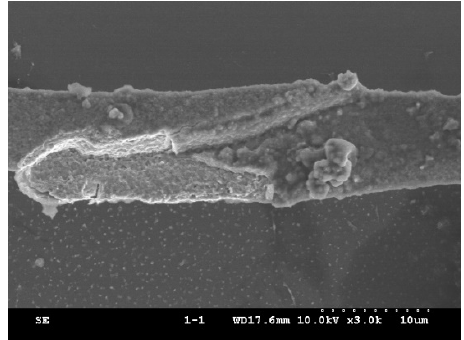
Figure 17. Crack defect under SEM.